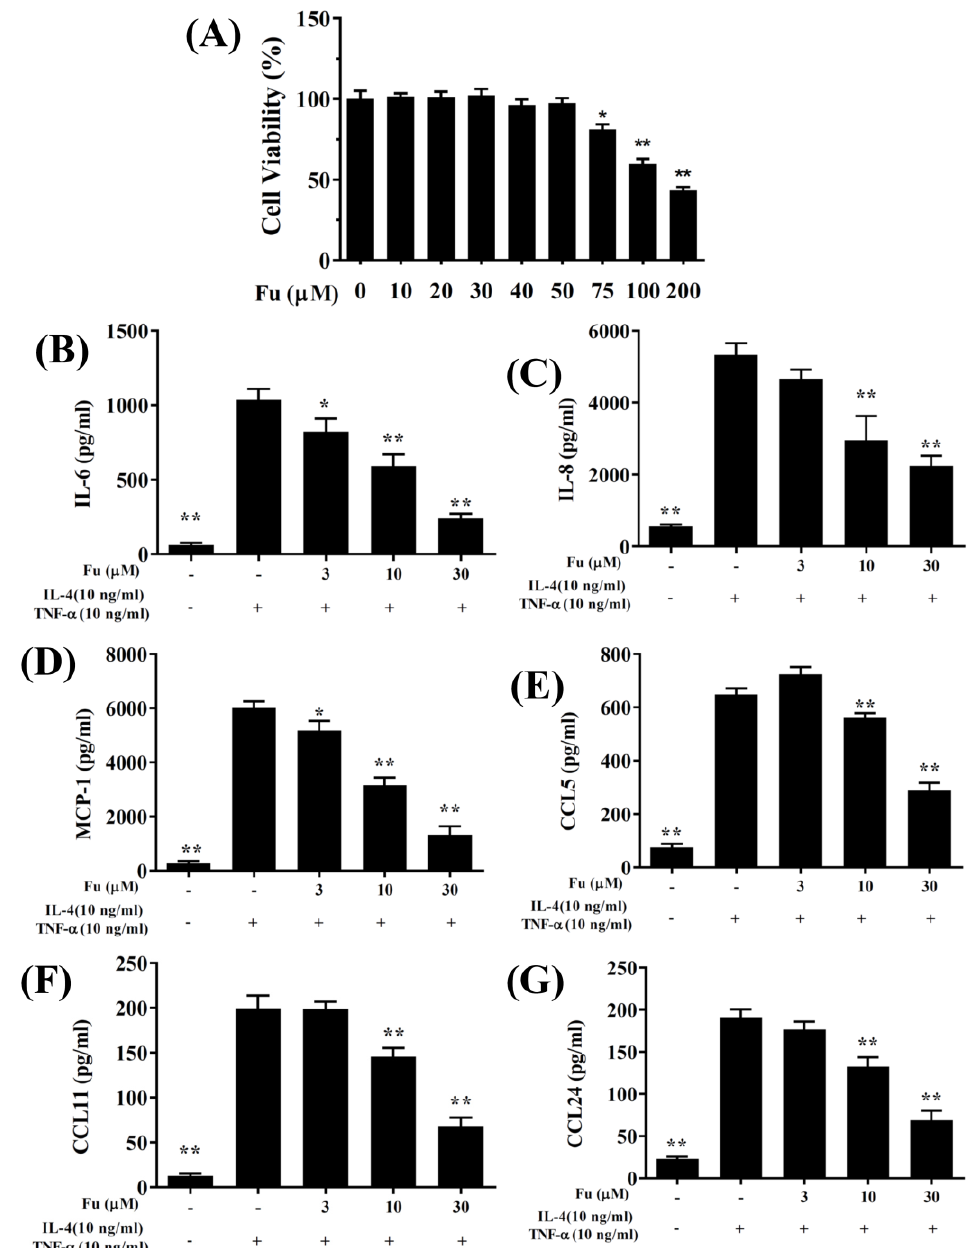
Figure 1. The effects of fucoxanthin (Fu) on cytokine and chemokine production in BEAS-2B cells. ( A ) Cell viability with increasing concentrations of Fu. ( B ) ELISA results for IL-6, ( C ) IL-8, ( D ) MCP-1, ( E ) CCL5, ( F ) CCL11, and ( G ) CCL24 levels in BEAS-2B cells treated with TNF- α /IL-4 and/or Fu. Three independent experiments were analyzed. Data are presented as the mean ± SEM. * p < 0.05, ** p < 0.01 compared to BEAS-2B cells stimulated with TNF- α and IL-4.